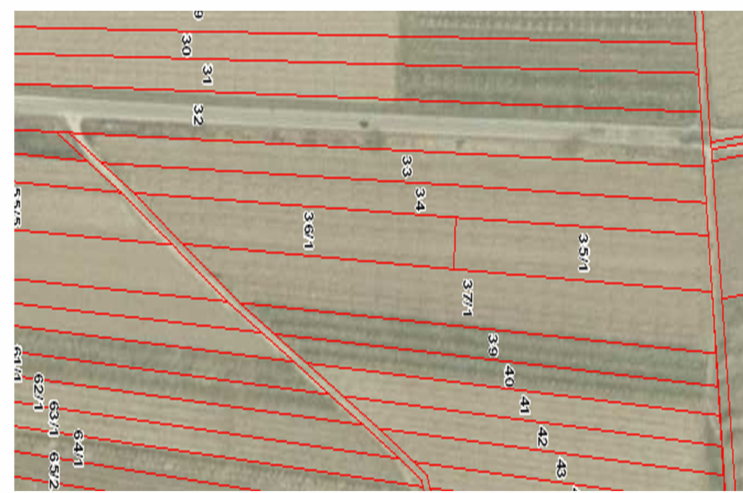
Figure 2. Plan of plots for hop cultivation on farm A (71, 72,